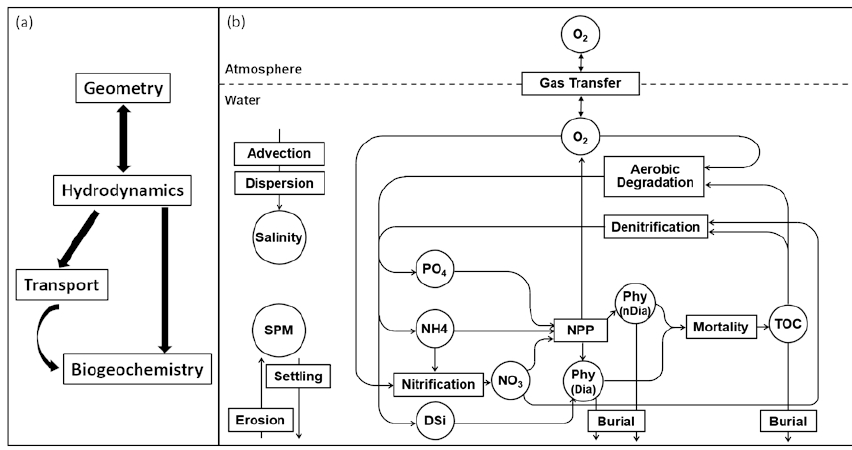
Figure 2. (a) The C-GEM concept. (b) Conceptual scheme of the biogeochemical module used in C-GEM in this study. A circle represents the state variables, while a rectangle represents the processes, and Dia corresponds to diatoms. Table 3. State variables in C-GEM and the boundary